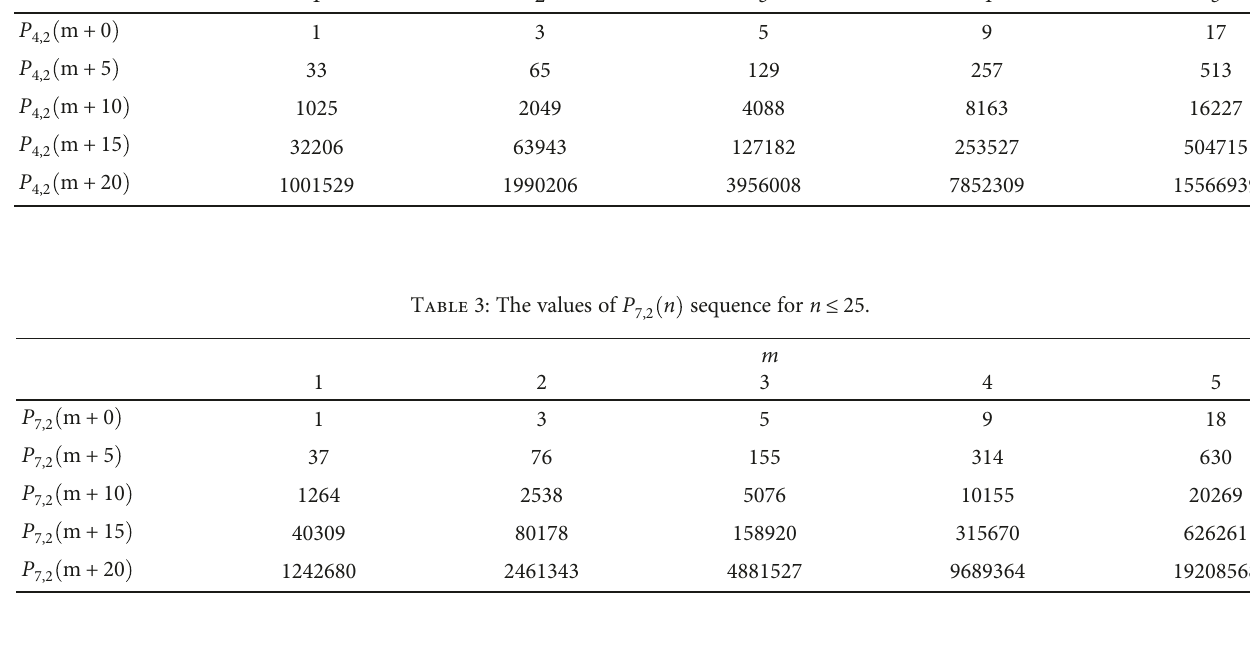
Table 4: The values of P